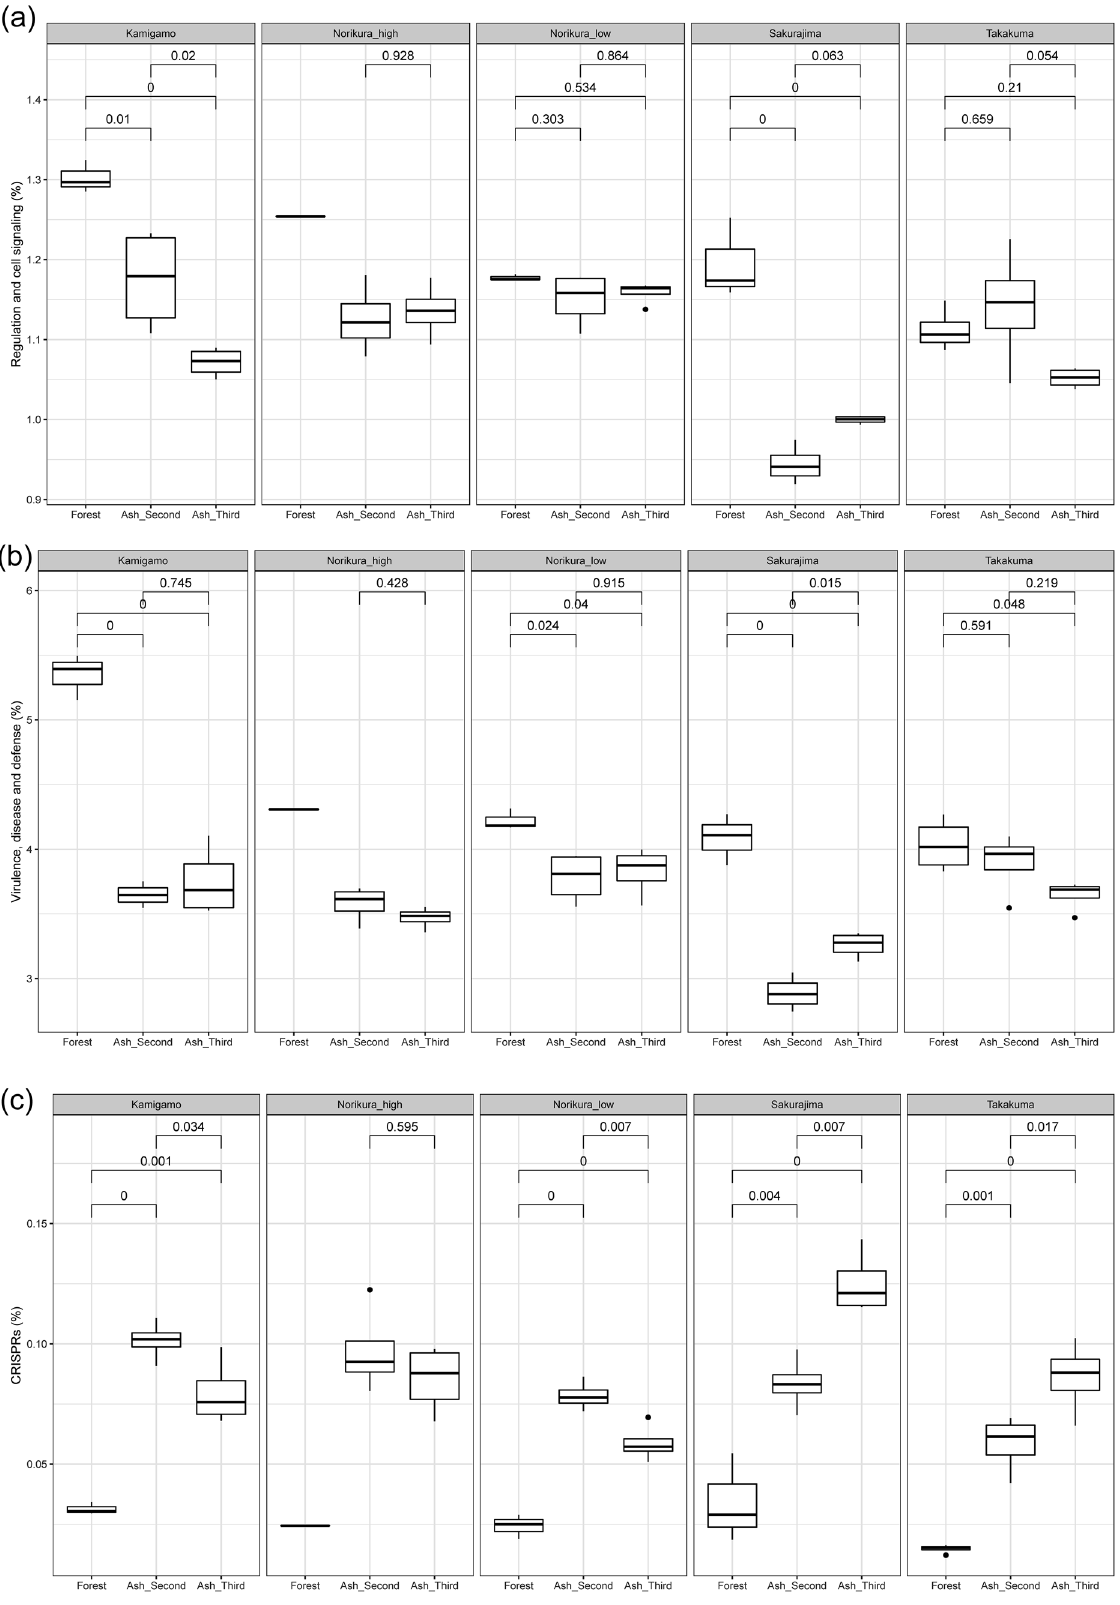
Figure 7. ( a ) Relative abundance of regulation and cell signalling gene category in the ash soil and forest soil. ( b ) Relative abundance of virulence, disease, and defense gene category in the ash soil and forest soil. ( c ) Relative abundance of CRISPR genes in the ash soil and forest